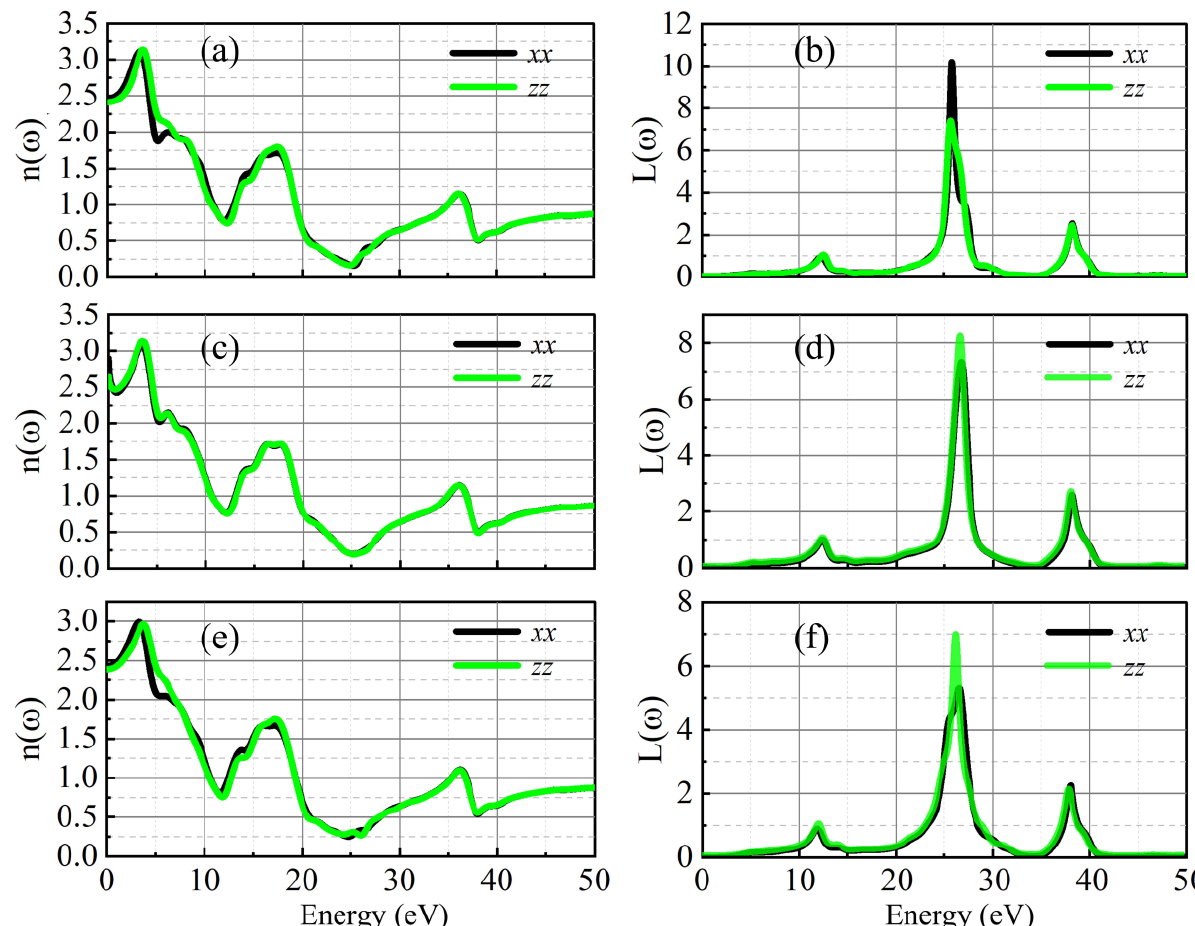
Figure 7. The refraction spectra ( a , c,e ) and energy loss function (ELF) ( b , d , f ) of BaTiO 3 ( top ), Ba 0.875 Ce 0.125 TiO 3 ( middle ), and BaTi 0.875 Ce 0.125 O 3 ( bottom ).